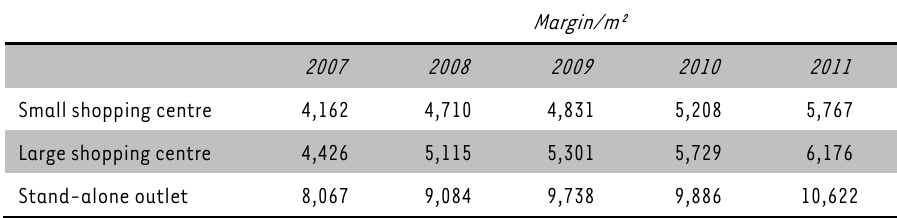
TABLE 9: Gross margin per m² by retail format type